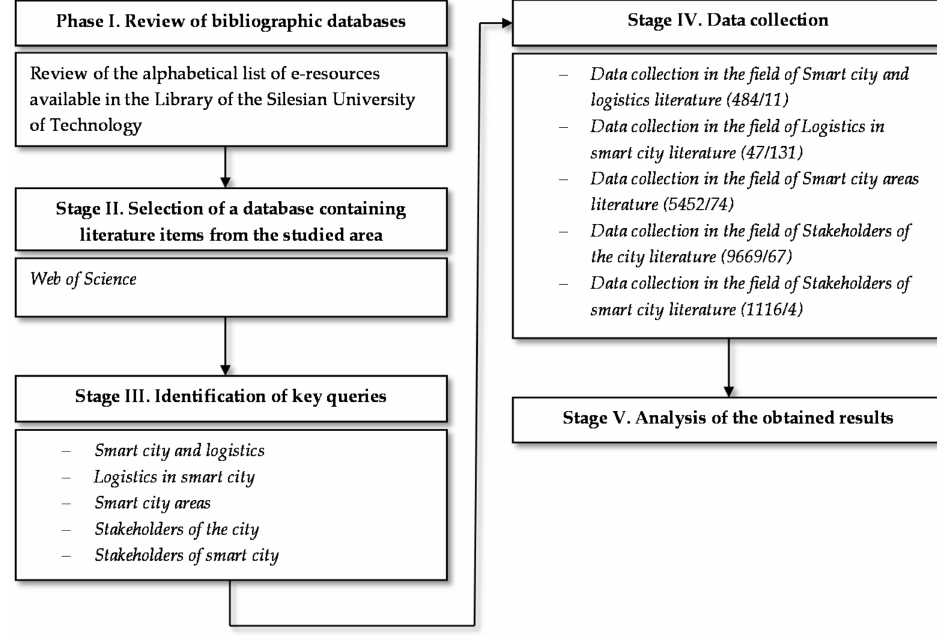
Figure 2. Stages of the bibliometric analysis of the literature. Table 2. A numerical analysis of the